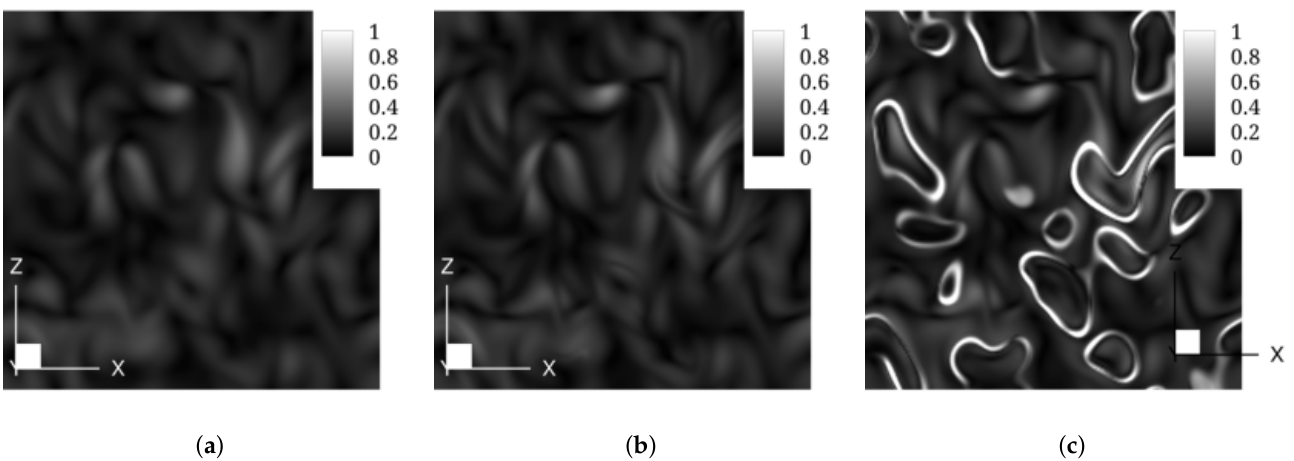
Figure 7. Vorticity module contours for the case HAT-200 in the central ‘x-z’ cross-section plane at three different time instances corresponding to: ( a ) t = 0.6 ms—before the auto-ignition; ( b ) t = 0.9 ms—the first auto-ignition spots appear; ( c ) t = 1.0 ms—the flame expands along the ‘x-z’ directions and across the mixing layer in the ‘y’